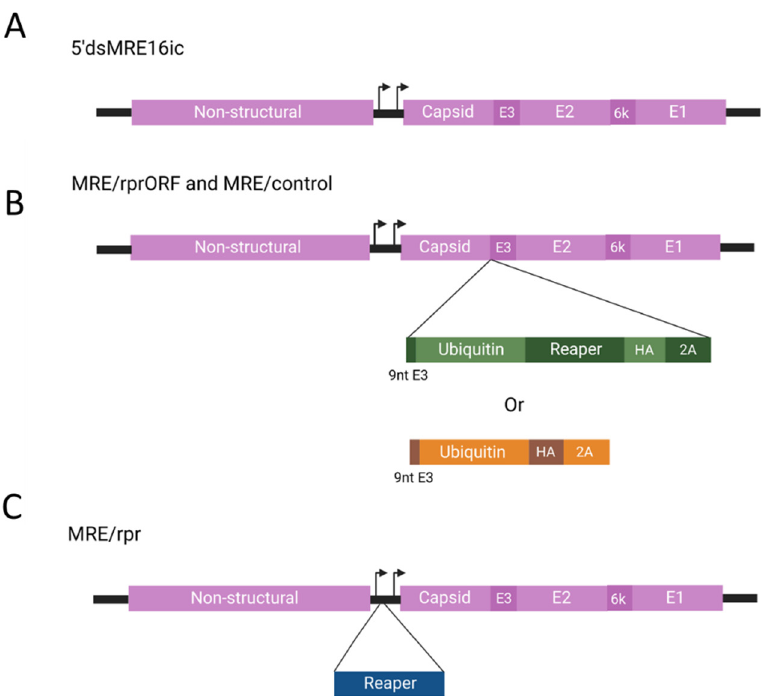
Figure 1. Diagrams of virus constructs used in this study (not drawn to scale). ( A ) 5 ′ dsMRE16ic was used as the starting backbone for the other viruses and does not contain any inserted sequences in the duplicated subgenomic promotor region or the structural ORF. Arrows indicate subgenomic promoter transcription start sites. ( B ) MRE/rprORF and MRE/control contain sequences inserted after the final codon of the capsid sequence in the structural ORF. In both constructs, the first nine nucleotides of PE3 are duplicated following the capsid to allow autoproteolytic activity of the capsid. Immediately following the PE3 insertion, MRE/rprORF contains a ubiquitin-reaper fusion with an HA tag. MRE/control contains ubiquitin and HA but does not contain reaper . The inserted sequence of both constructs ends with FDMV 2A which will release peptides as they are translated. ( C ) MRE/rpr contains the reaper gene inserted in the duplicated subgenomic promoter region. The